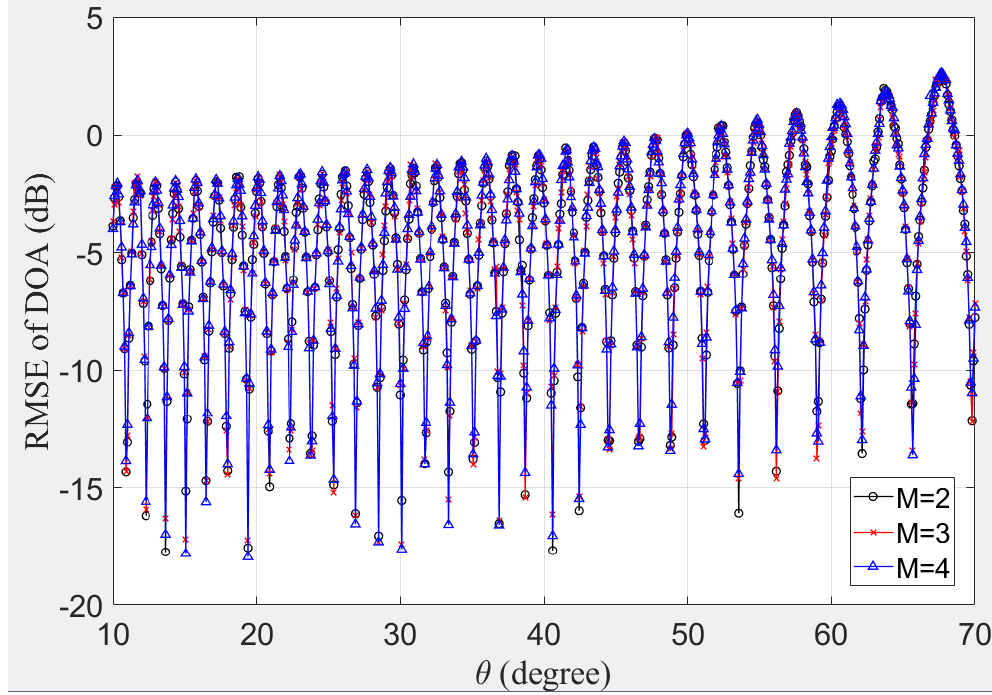
Figure 4. Root mean square error (RMSE) of DOA versus the incident